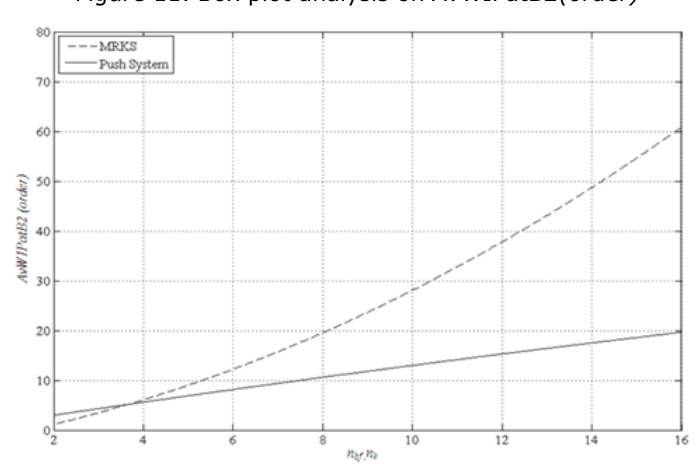
Figure 11. Box plot analysis on AvWIPatB2(order)